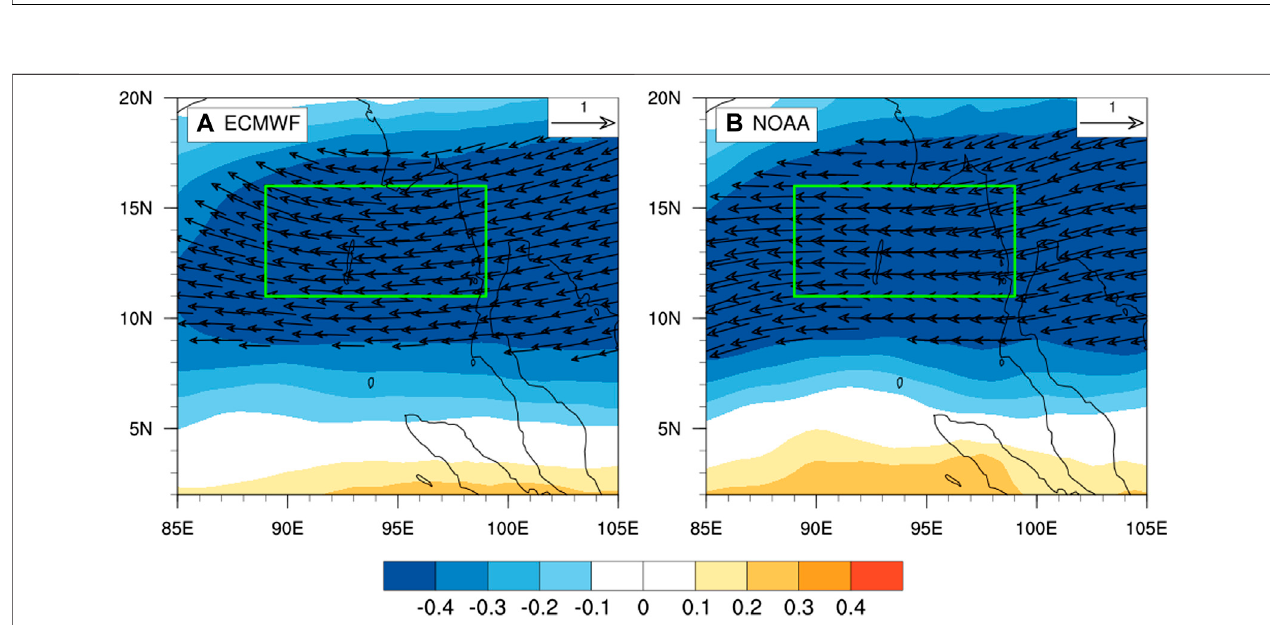
FIGURE6| Regression(vector;unit:m s − 1 )andcorrelation(shading)oftheApril500-hPawindanomaliesonthenumberofTClandfallsusing (A) ECMWF(1979 – 2005)and (B) NOAAdata(1982 – 2005).Eitherzonalwindormeridionalwindstatisticallysigni fi cantatthe95%con fi dencelevelareshown.Shadingindicatestheareaswherethecorrelation coef fi cients of the zonal wind anomalies are signi fi cant at the 95% con fi dence level. The regions of U500 BOB,4 are speci fi ed by the green rectangles.